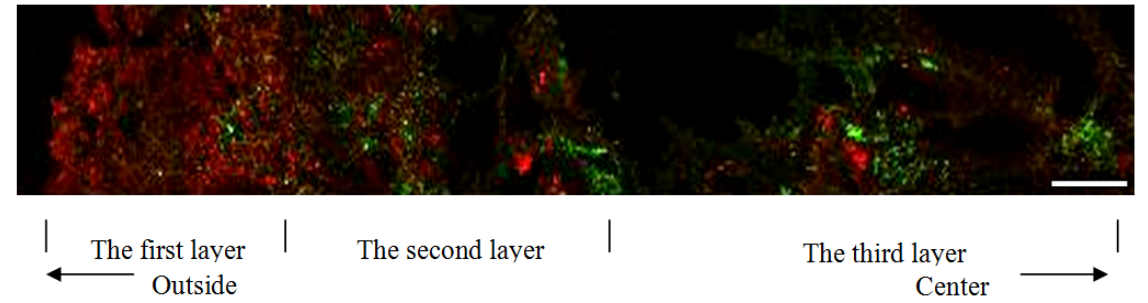
Figure 7. Distribution of bacteria (red) and EPS (green) in a granule by CLSM (scale bar = 0.1 mm).